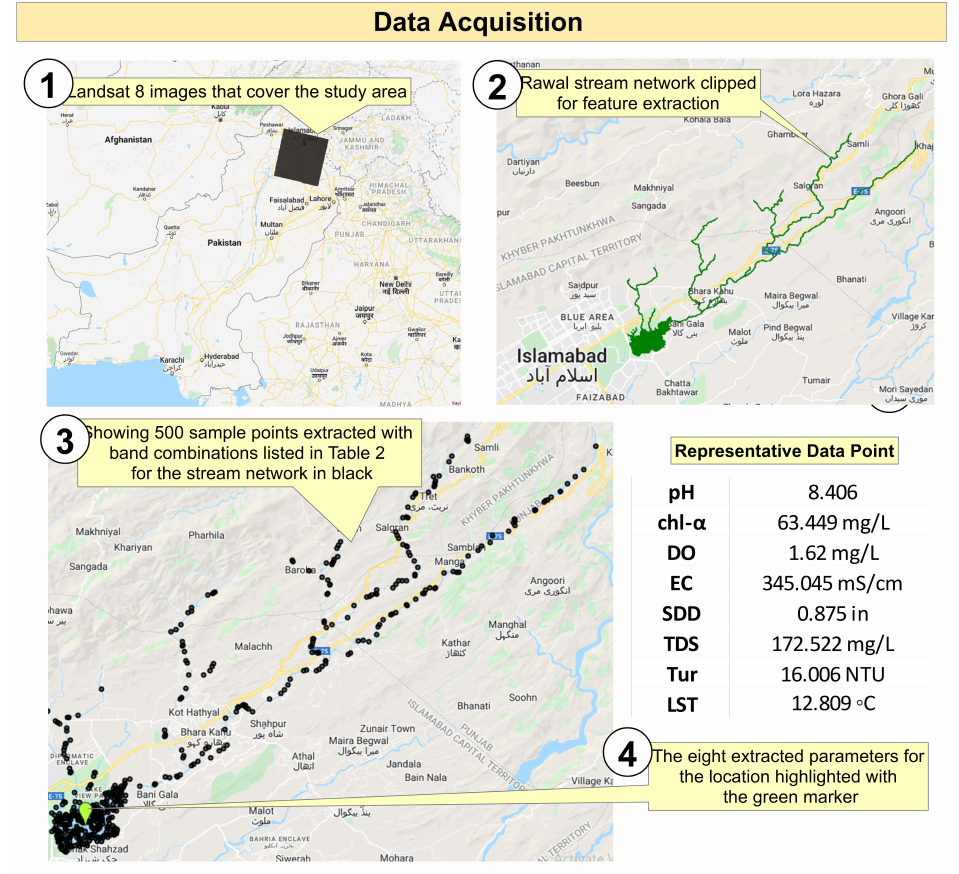
Figure 3. Data acquisition process for a single mosaicked Landsat